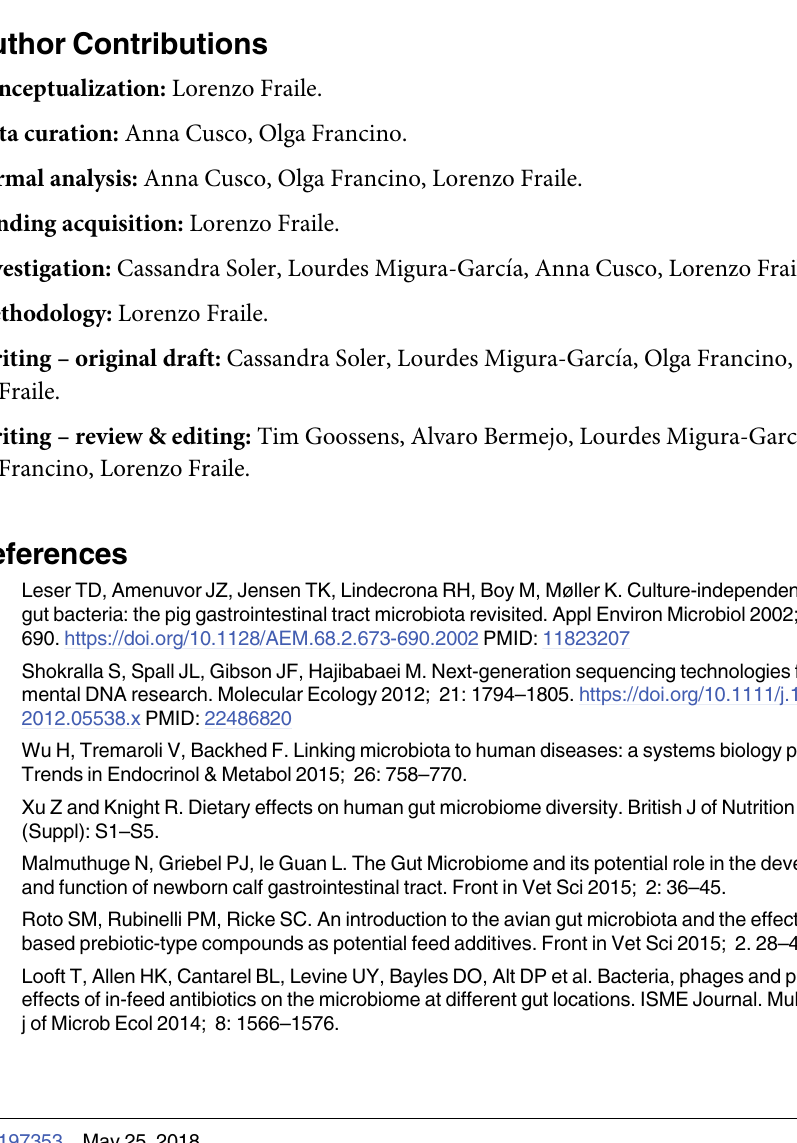
S1 Table. Productive performance of the piglets included in the trial. Selected piglets for microbiota analysis are